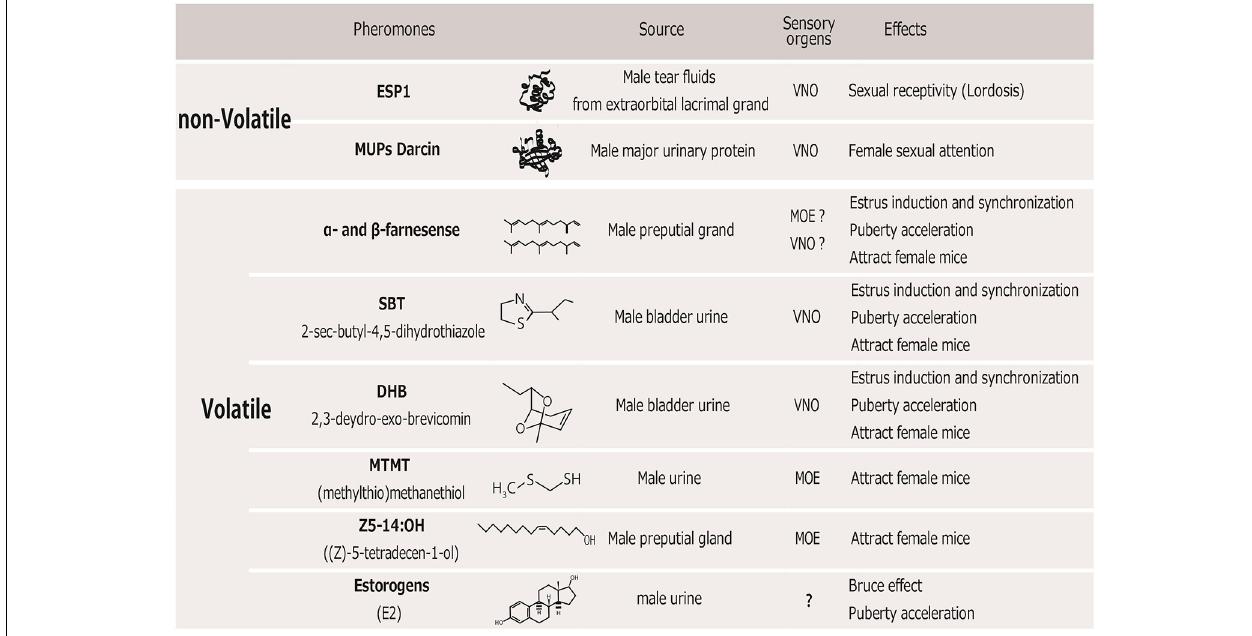
Frontiers in Neuroscience | Neuroendocrine